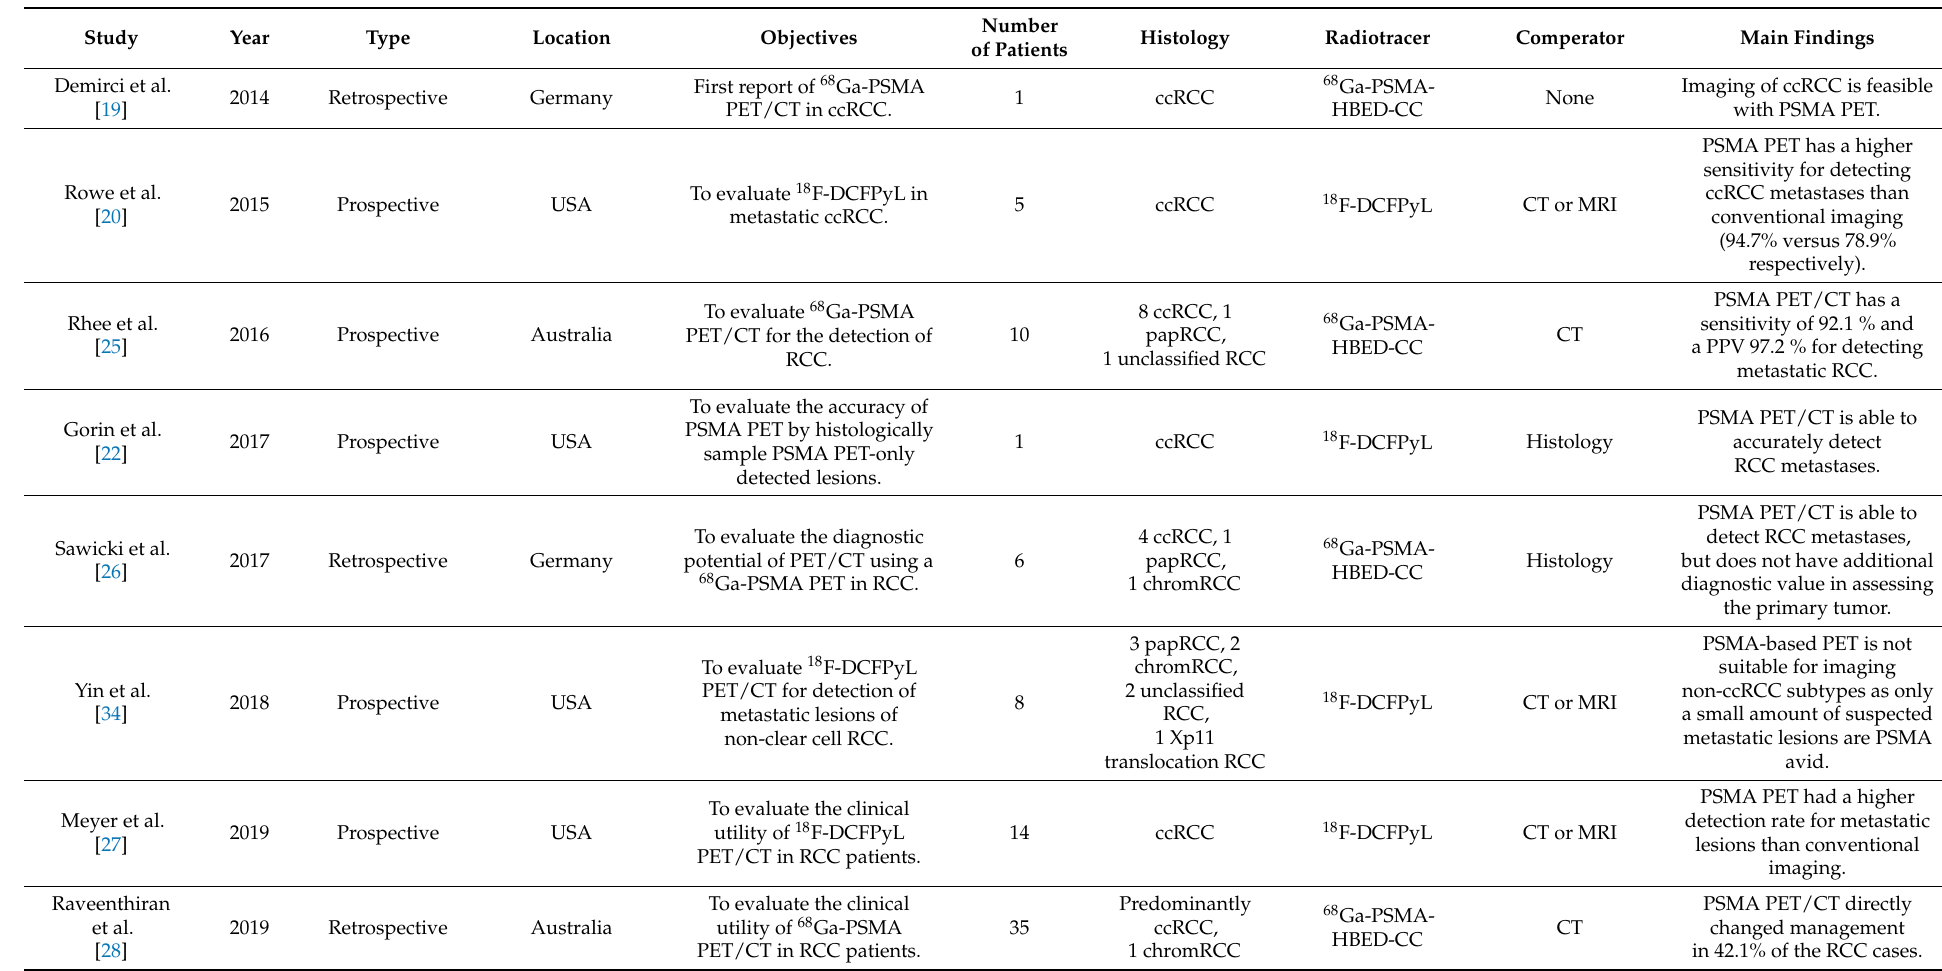
Table 1. Literature overview on PSMA PET in renal cell